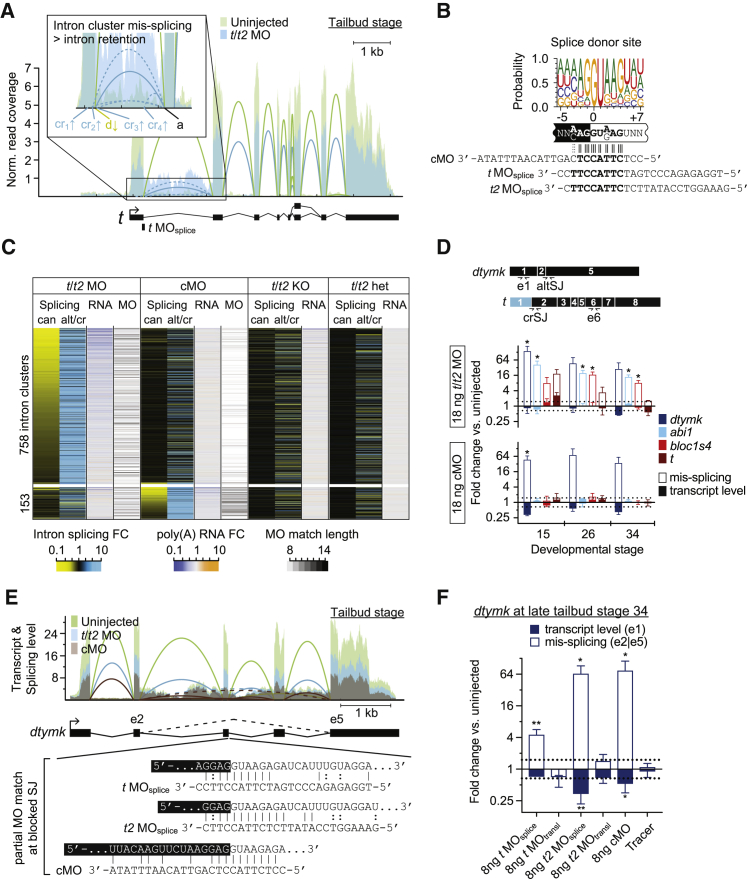
MOs Can Cause Off-Target Mis-splicing(A) Quantitative comparison of t transcript levels and splice junction usage between t/t2 MO-injected and uninjected tailbud embryos in a superimposed Sashimi plot. Canonical and cryptic splicing are shown with solid and dashed lines, respectively. Magnification of the first intron indicates position and altered usage (see arrow after abbreviation for various splice sites) of splice junctions caused by the t donor splice-blocking MO (MOsplice): a, acceptor splice site; d, canonical donor splice site; cr1-4, cryptic splice sites.(B) Consensus sequence of all canonical donor splice junctions detected in the transcriptome of X. tropicalis tailbud embryos and best alignment with control and donor splice-blocking MOs.(C) Seriated heatmap of differentially used intron clusters, transcript level changes, and MO match length at blocked splice junctions for indicated conditions compared with their uninjected controls. Selected intron clusters represent coupled splicing events that were inversely mis-regulated in either t/t2 MO- or cMO-injected tailbud embryos: inhibition of canonical (can) splicing caused alternative or cryptic (alt/cr) splice sites to be used more frequently. Blocked splice sites, 758 in t/t2 morphants and 153 control morphants, were observed with higher occurrences of reduced transcript levels (<67%; 165:54 and 19:1, respectively) and more consecutive MO base pairing (≥10; 92:26 and 49:2, respectively) than expected (nobs:nexp).(D) Temporal dynamics of mis-splicing (solid bar) and transcript (filled bar) fold changes (log2 scale) for transcripts dtymk, abi1, bloc1s4, and t in control (cMO) and t/t2 morphants (t/t2 MO) from neurula (stage 15) to mid-tailbud (stage 26) to late tailbud stage (stage 34). Mis-splicing was quantified by qRT-PCR (n = 3, mean ± SD) using forward primers that span alternative or cryptic splice junctions (altSJ/crSJ) as shown above the bar graph for dtymk and t. Cryptic splice junction shortens first exon of t (colored blue). Changes in transcript levels were determined at indicated exons (e). See Key Resources Table for the design of qRT-PCR primers.(E) Superimposed Sashimi plot of transcript dtymk whose splicing was affected by both cMO and t/t2 MO at tailbud stage. Canonical and alternative (between exons 2 and 5) splicing are shown with solid and dashed lines, respectively. The blocked donor splice site featured partial matches of ≥8 consecutive bases with the MOsplice of t and t2 as well as the cMO. The alignments show canonical Watson-Crick (vertical bar) and non-canonical wobble (colon) base pairing between the transcript and several MOs.(F) Confirmation of the alignment-based predictions in E by injecting single MOs or tracer sulforhodamine as indicated. Fold changes (log2 scale) to the alternative splicing and transcript level of dtymk were quantified by qRT-PCR (n = 4, mean ± SD).Two-tailed t test: ∗p < 0.1; ∗∗p < 0.01.